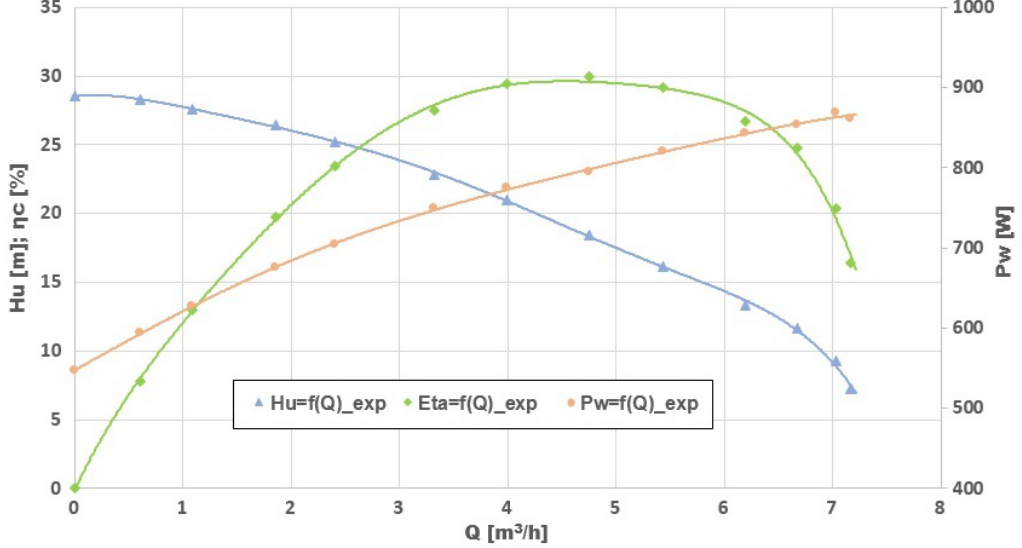
Figure 5: Characteristics of the model pump with an annular casing and a multi-piped